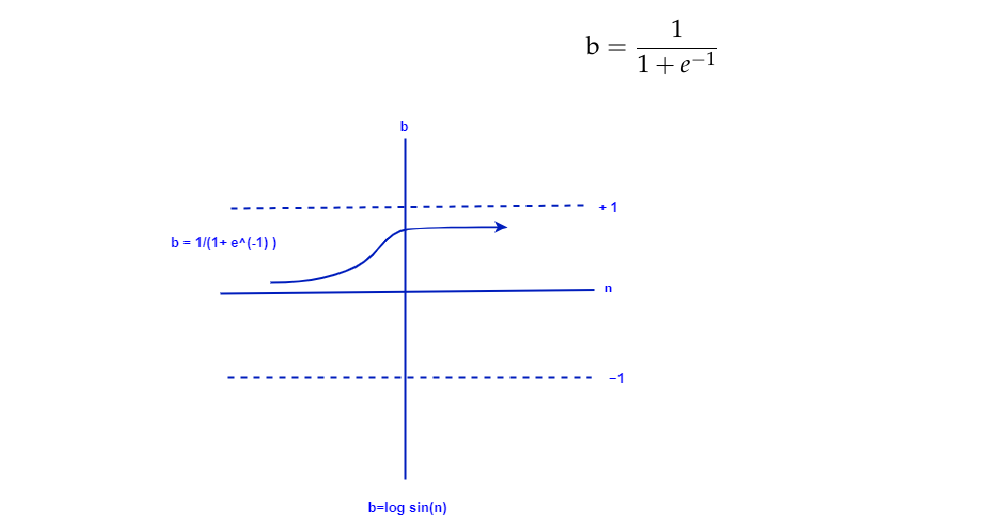
Figure 8. Log-sigmoid transfer function.